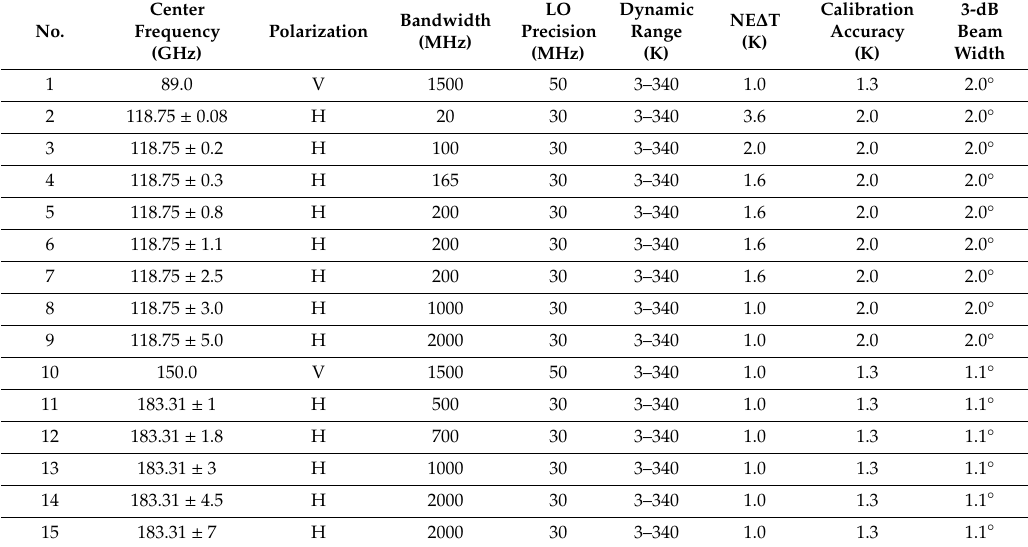
Table 1. Channel characteristics of MWHTS